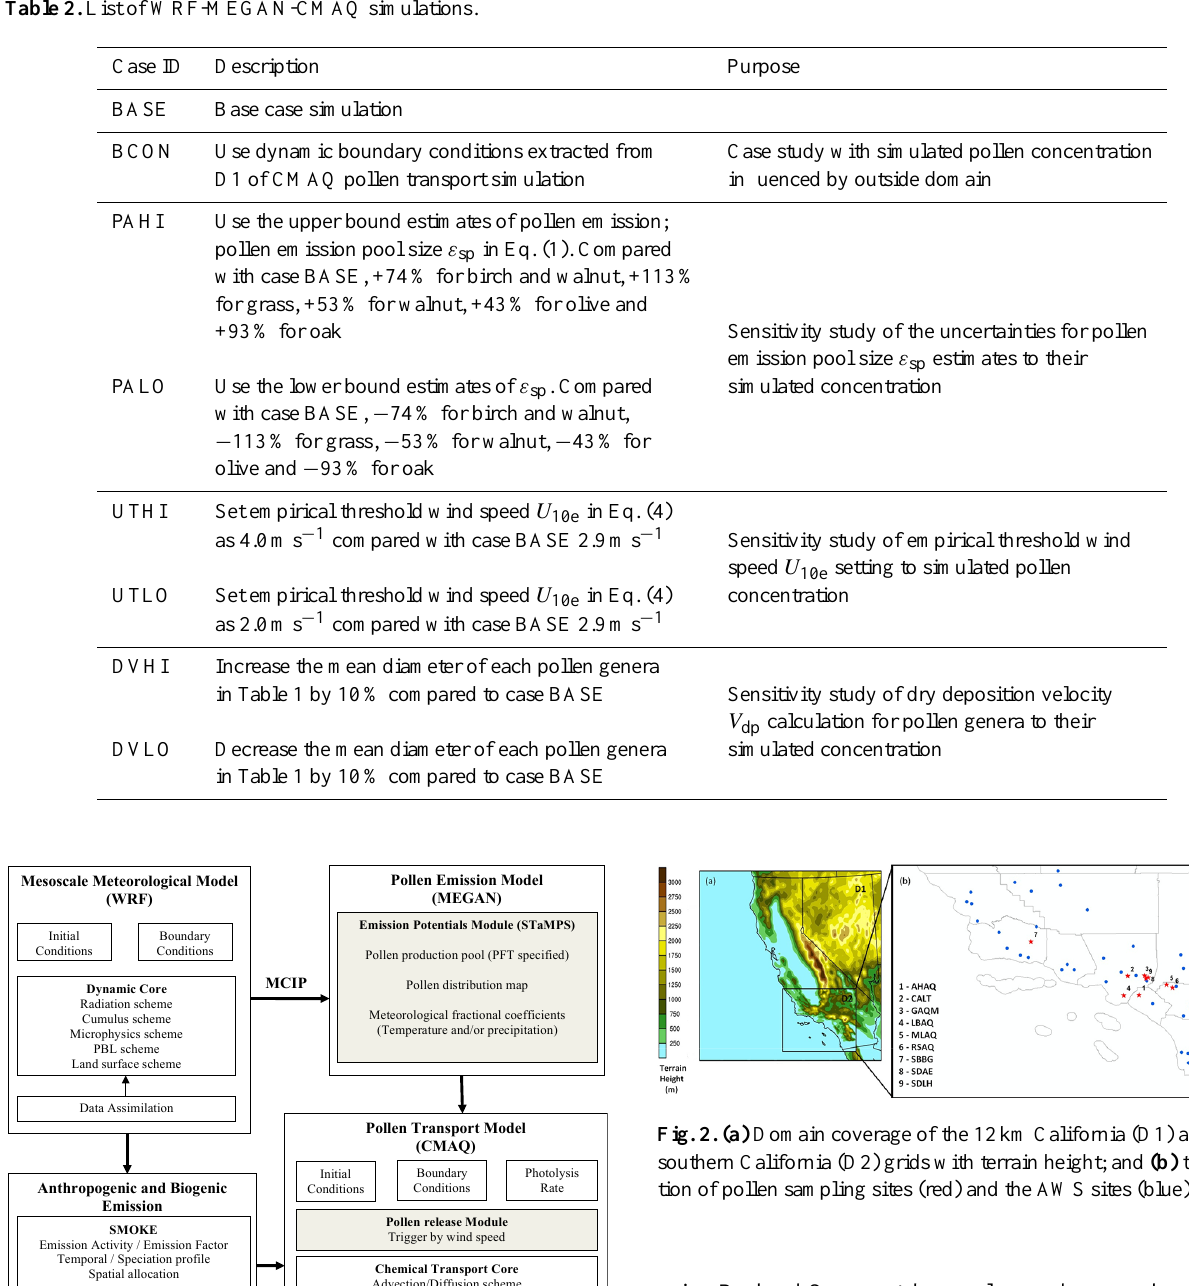
Table 2. List of WRF-MEGAN-CMAQ simulations.